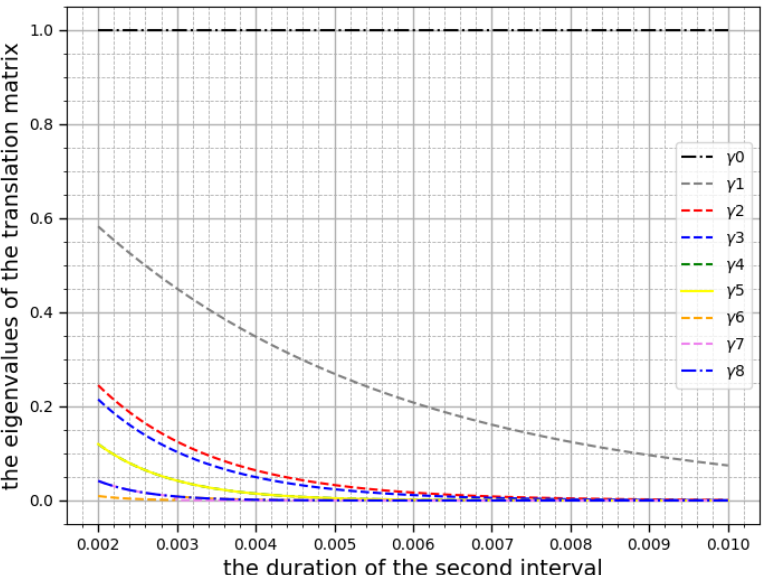
Figure 5. Dependencies of modules of eigenvalues of the probability translation matrix ( t = 0.002 ÷ 0.01).